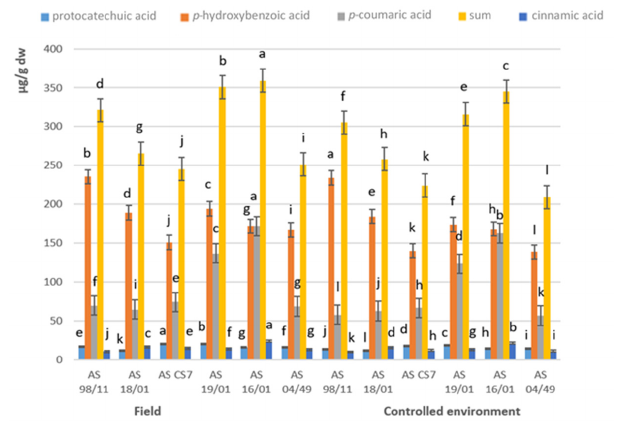
Figure 5. Content of phenolic acids and related compounds of the studied Agaricus subrufescens samples produced in the field and in controlled environment crops. Mean values ( n = 3); identical superscripts (a–l) denote no significant ( p < 0.05) difference between mean values in columns according to Tukey’s HSD test (ANOVA) for mushrooms produced in the field and in controlled environment